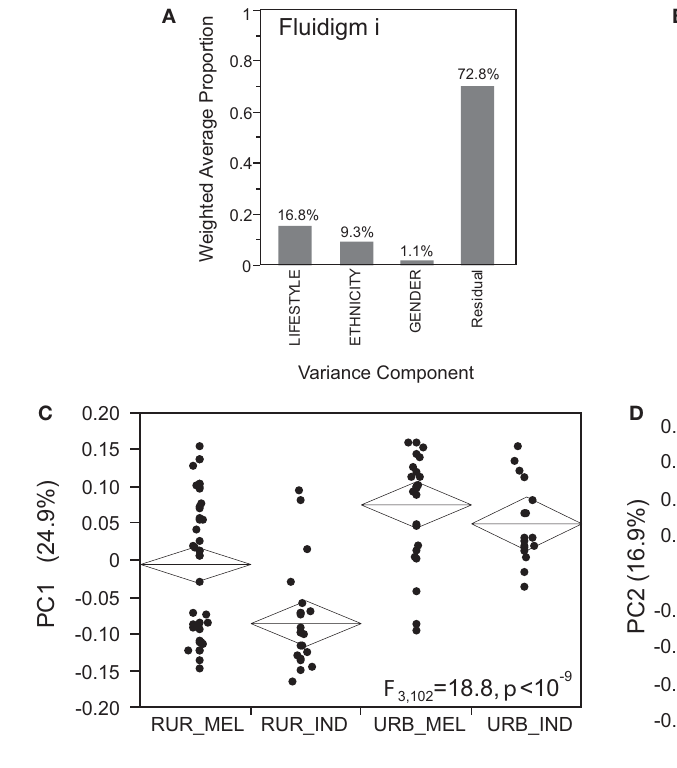
localities: rural Melanesian (RUR_MEL), rural Indians (RUR_IND), urban Melanesians (URB_MEL), and urban Indians (URB_IND). (C) PC1 appears to be divergent in Rural Indians (rural Indians lower, p < 10 − 9 ). (D) PC2 also appears to be divergent in urban Melanesians, but in experiment 2 it is only the rural Indians who have low scores, and the median urban Melanesian score here is elevated.